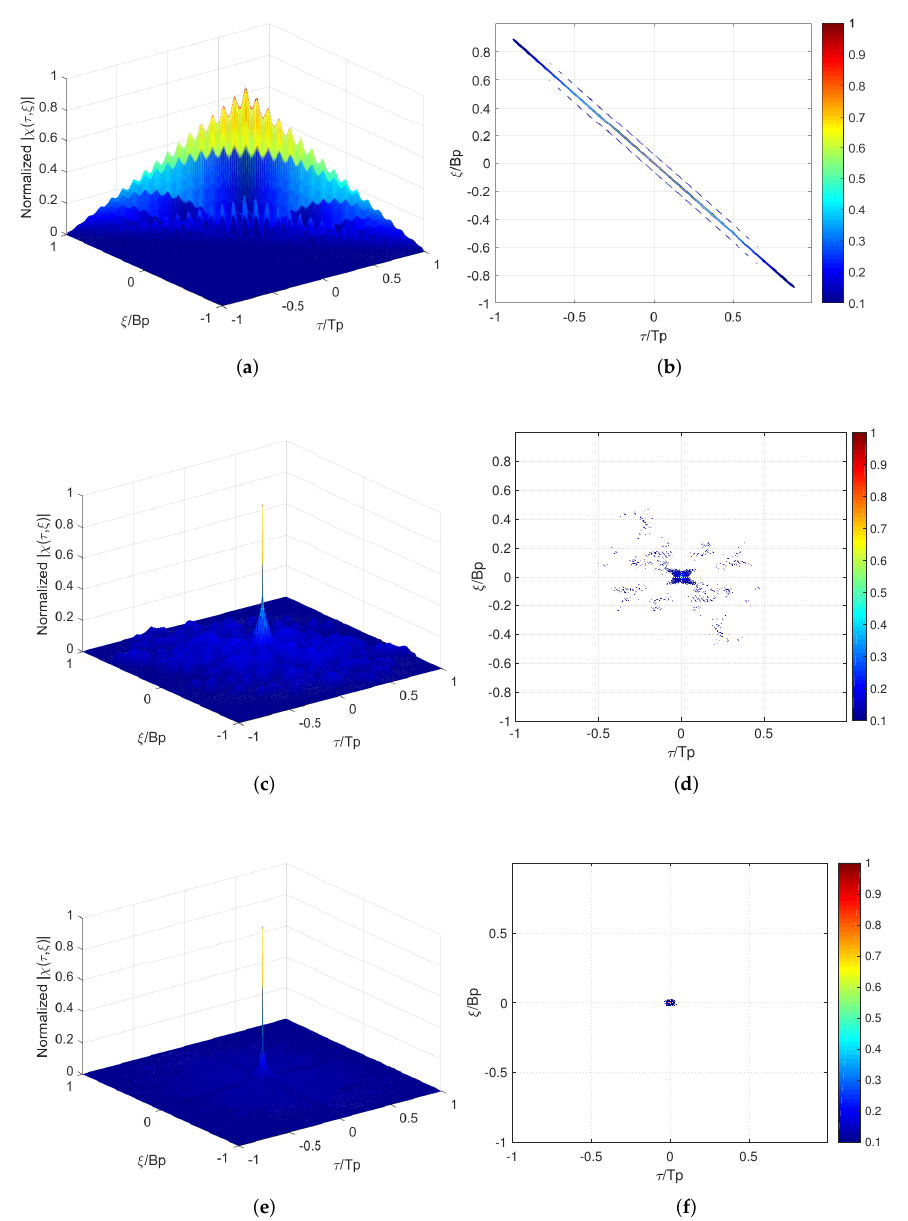
Figure 4. Ambiguity function plots(dB): ( a ) 3-D plot of the RSF-LS-DFC AF; ( b ) contour plot of the RSF-LS-DFC AF; ( c ) 3-D plot of the RSF-IC-DFC AF; ( d ) contour plot of the RSF-IC-DFC AF; ( e ) 3-D plot of the RSF-DC-DFC AF; ( f ) contour plot of the RSF-DC-DFC